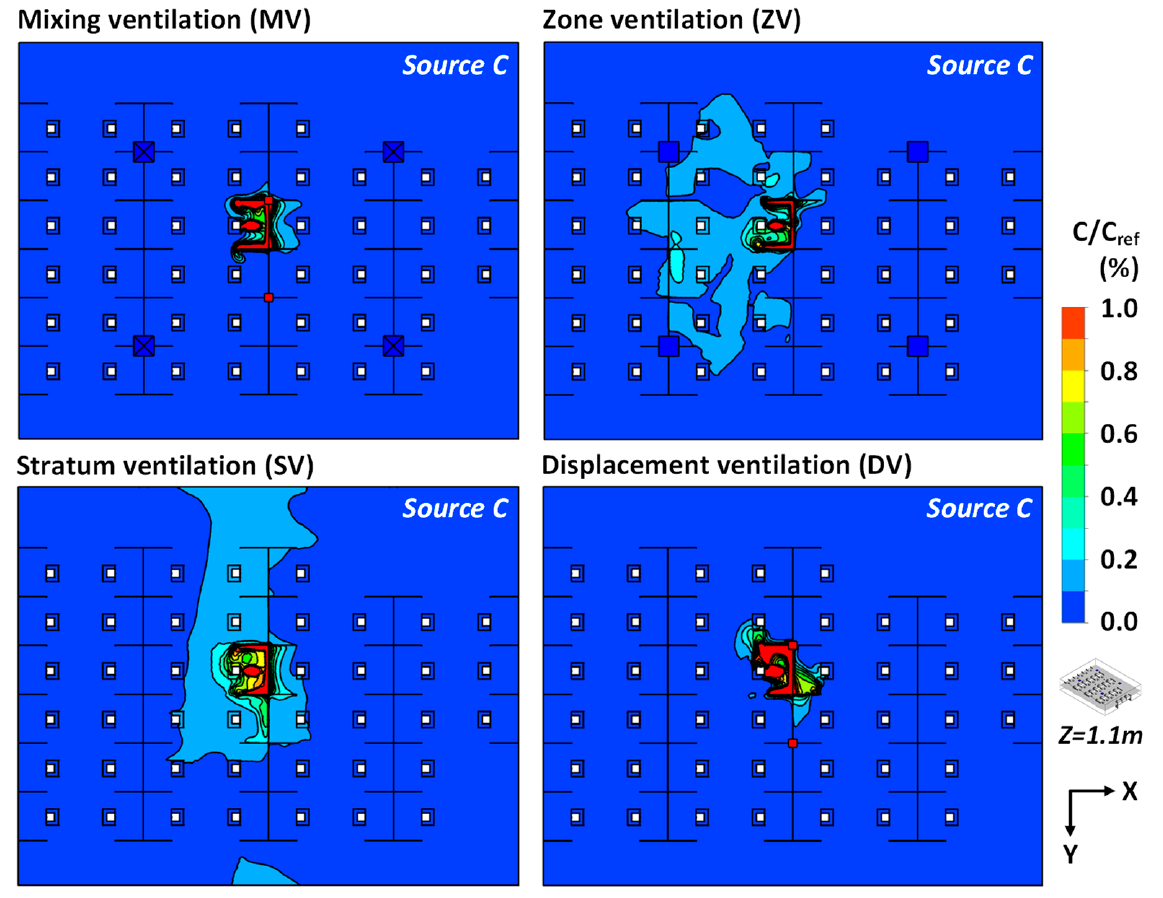
Figure 8. Distribution of relative pollutant concentration (C/C ref ) at the plane of Z = 1.1 m under different ventilation modes of MV, ZV, SV and DV and infected source of C (with a height of physical barrier of 0.6 m).